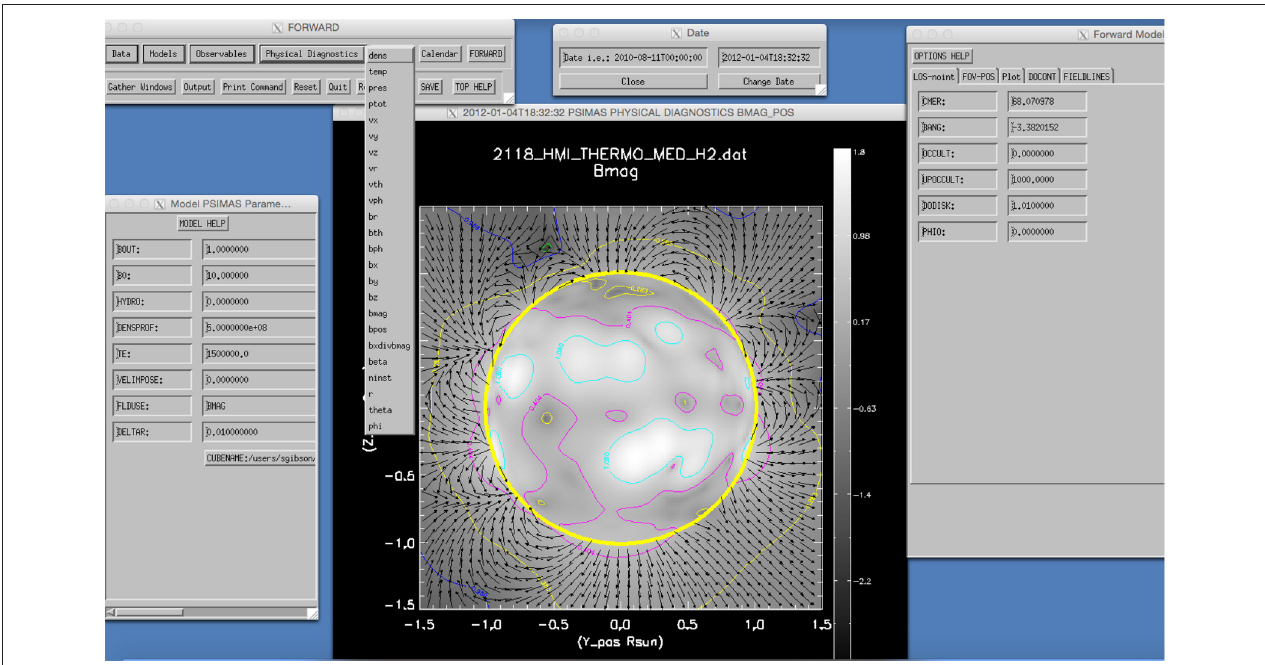
FIGURE 3 | Example of MAS model data cube loaded into FORWARD by date, and displaying magnetic field strength (contours) and field lines (black arrows) in the plane of the sky. As with the analytic model of Figure 2 , display options and model parameters can be set through the widgets. Descriptions of the model parameters and other options are found via the TOP HELP , MODEL HELP , and OPTIONS HELP buttons at the top of the three main widget windows. See Section 3 for further discussion and Figures 4 , 6 for examples of forward calculation using the MAS and PFSS models.